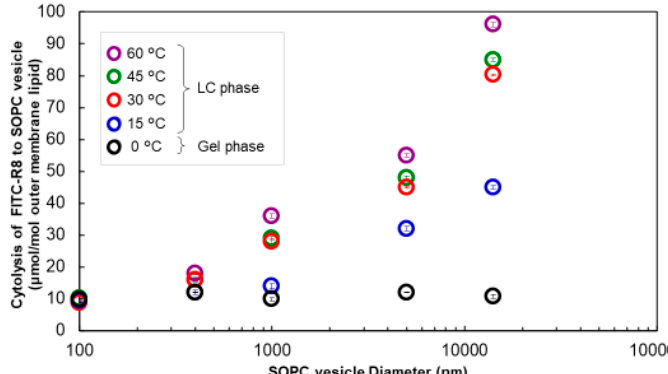
Figure 5. Influence of temperature on cytolysis of FITC–R8 to SOPC vesicle (SOPC; L/P = 1000, 10 min, n =